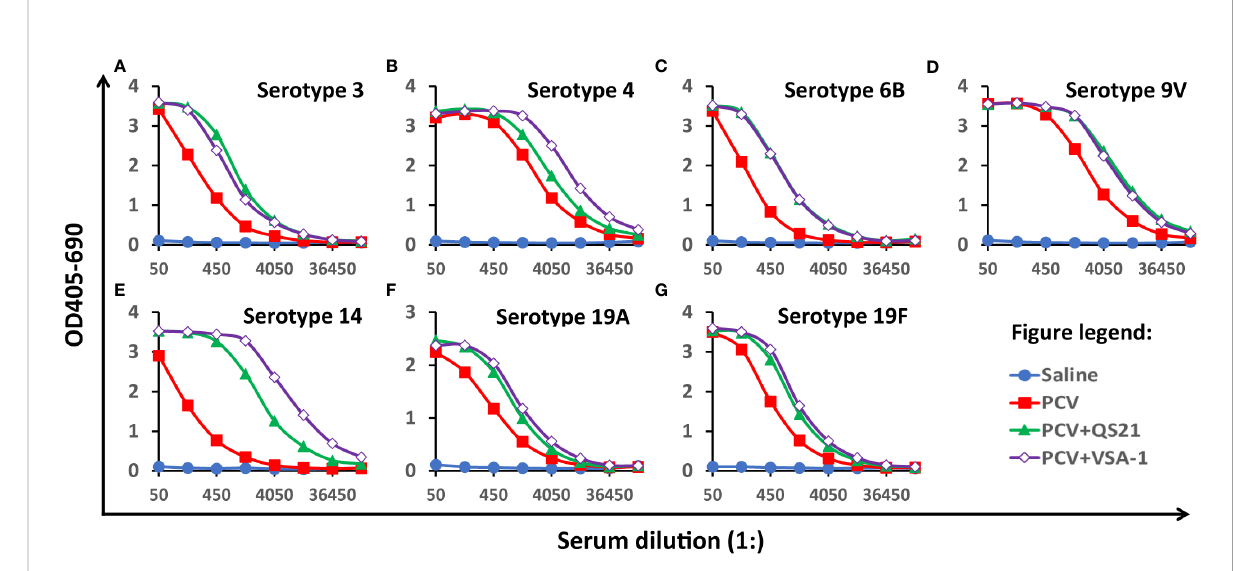
FIGURE 1 Serum antibody activity to seven serotypes on Day 42, (A) 3, (B) 4, (C) 6B, (D) 9V, (E) 14, (F) 19A, and (G) 19F. BALB/c mice (8-10 weeks of age, six per group) were immunized via the subcutaneous route ( s.c .) on days 0, 14 and 28. Serum samples were collected prior to the fi